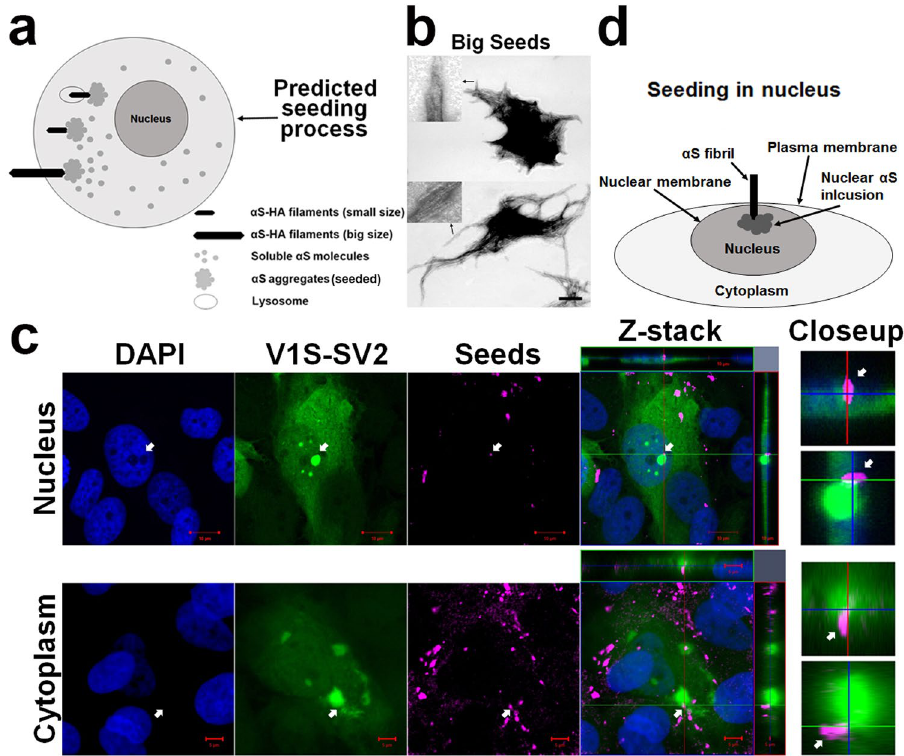
Figure 2. Evidence for a direct plasma membrane penetration seeding pathway. (a) Schematic of predicted seeding processes by small and large seeds. (b) Electron micrographs of large seeds. Scale bar: 500 nm. Different α S polymorphs are shown in two magnified inserts. (c) H4/V1S-SV2 cells were treated with α S-HA seeds for 2 days then subjected to immunocytochemistry with primary antibody against HA tag and Alexa Fluor 647-conjugated secondary antibody. Z-stack of merged pictures confirms the intracellular location of seeded inclusions and partial-internalization of large seeds in recipient cells. Arrows denote the seeded α S inclusions formed in nucleus (top row) and cytoplasm (bottom row). Scale bar: 10 µ